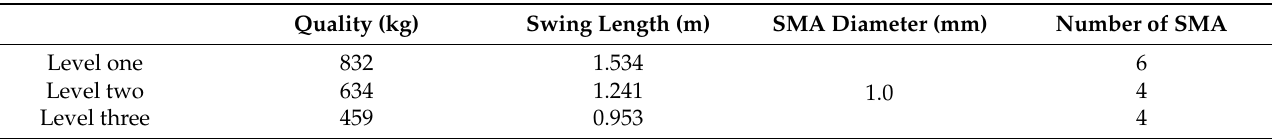
Table 8. The recommended design value of the SMA-SPDS parameters for the prototype structure of the Small Wild Goose Pagoda.